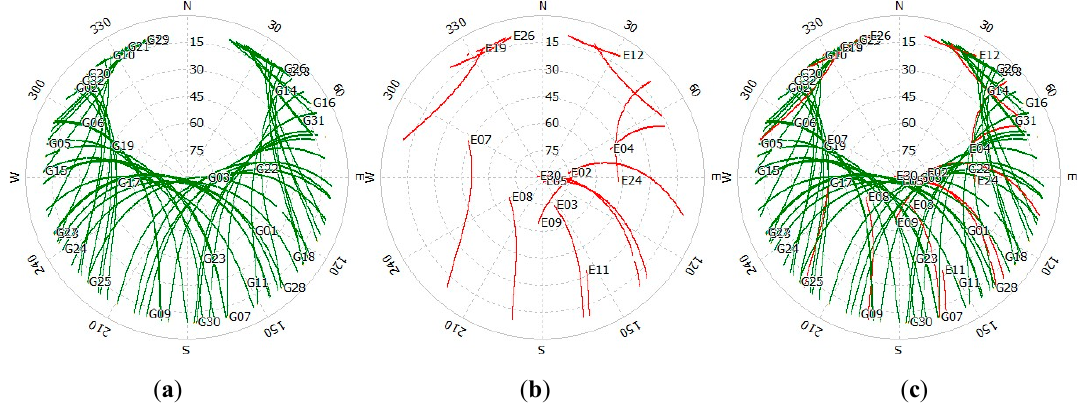
Figure 3. Sky plots (azimuth vs. elevation) for the various satellites systems at station shm1 on May 2nd, 2018: ( a ) global positioning system (GPS); ( b ) Galileo; and, ( c ) GPS/Galileo.